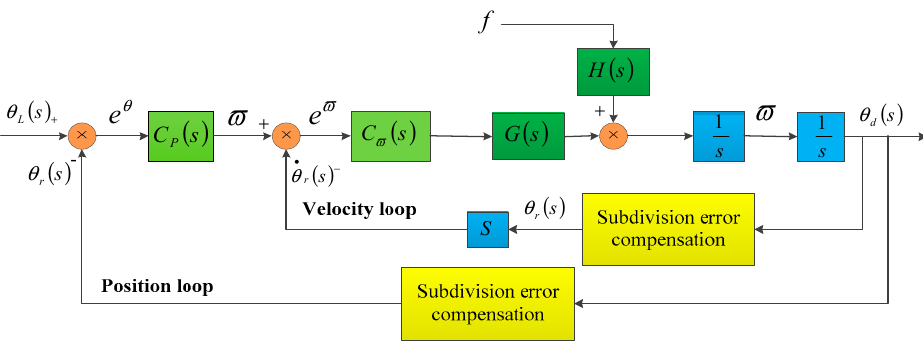
Figure 10. Control system based on classical double-loop structure.